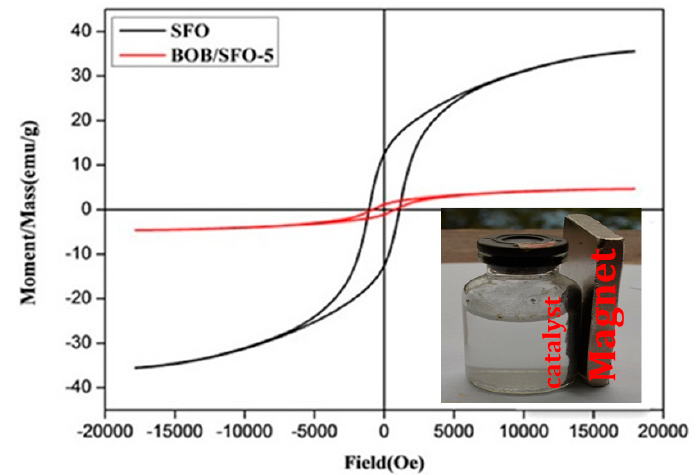
Figure 5. Magnetic hysteresis loops of BOB / SFO-5. Inset shows the magnetization of BOB / SFO-5 in a magnetic field.